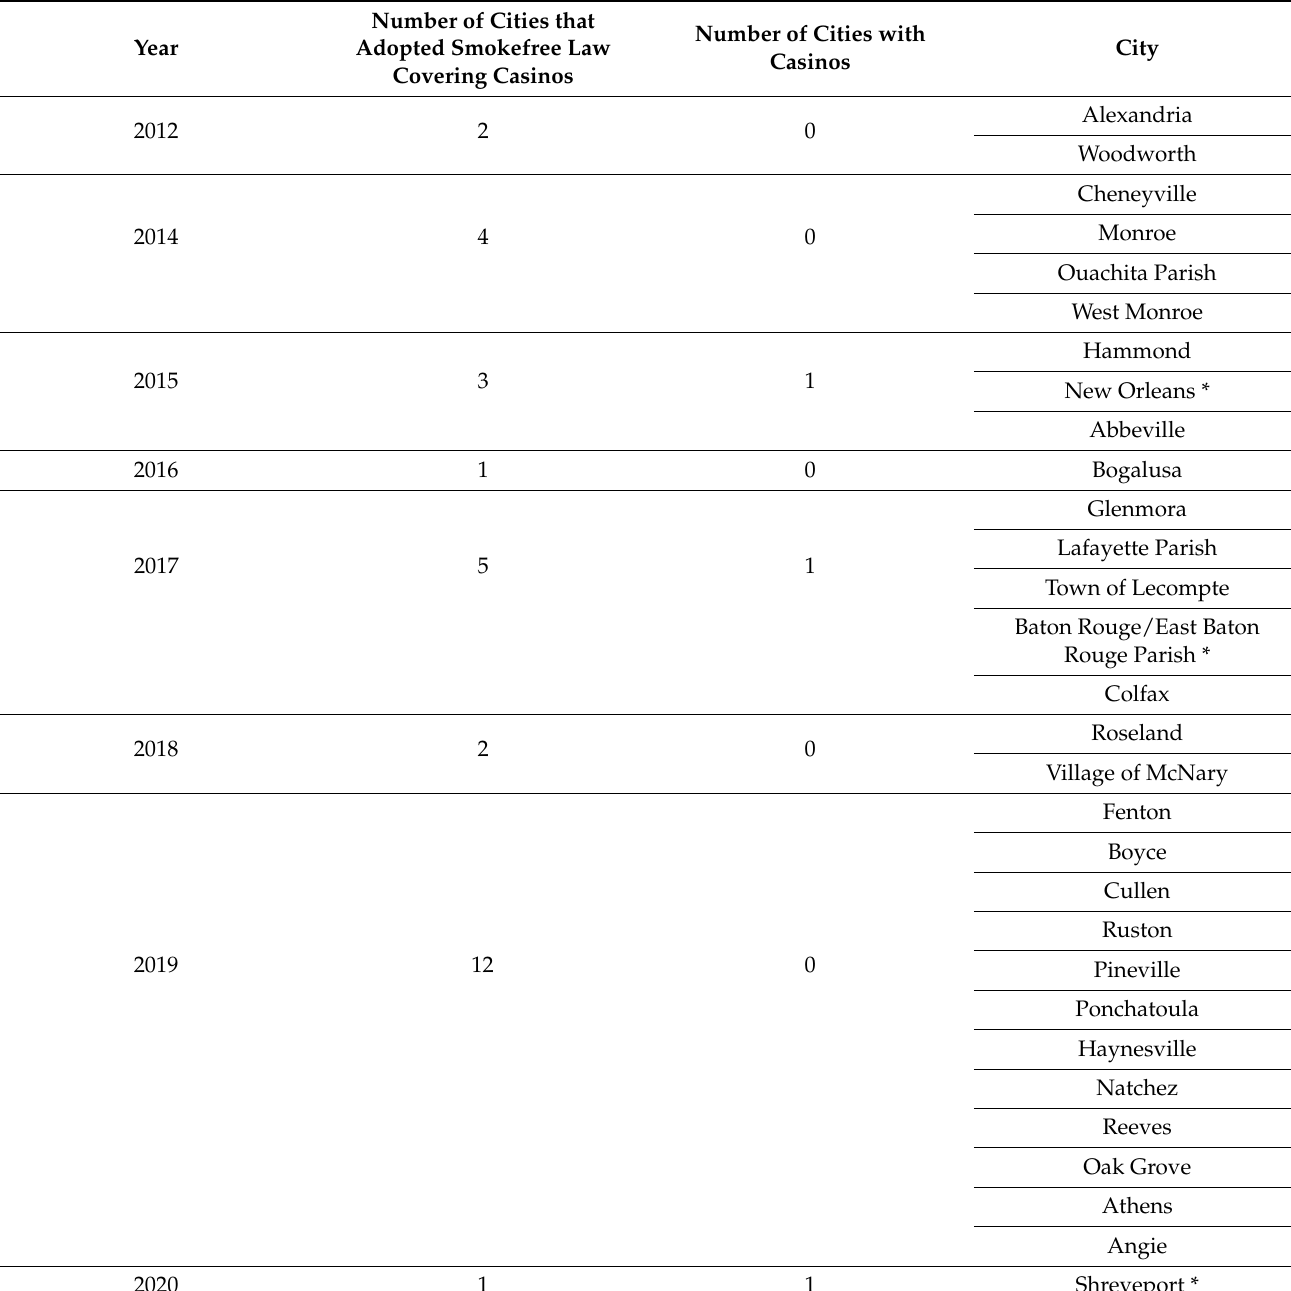
Table 1. Localities in Louisiana with 100% Smokefree Laws including Casinos